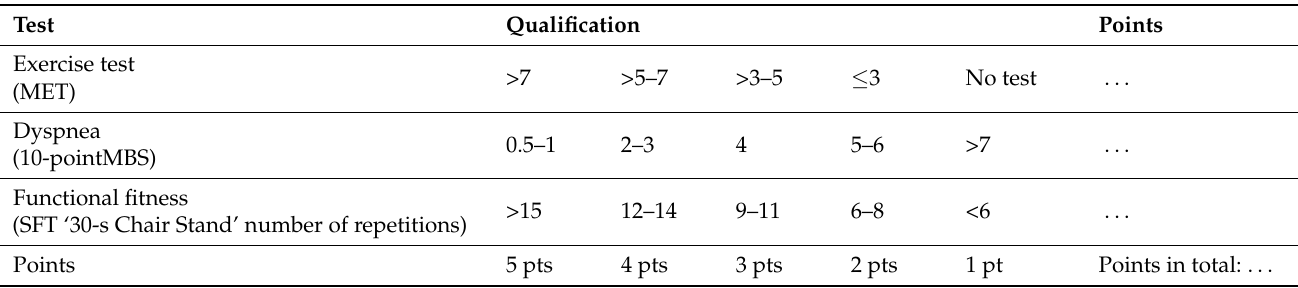
Table 3. Qualification Card for the post-COVID-19 Rehabilitation Program used by physical therapists, part